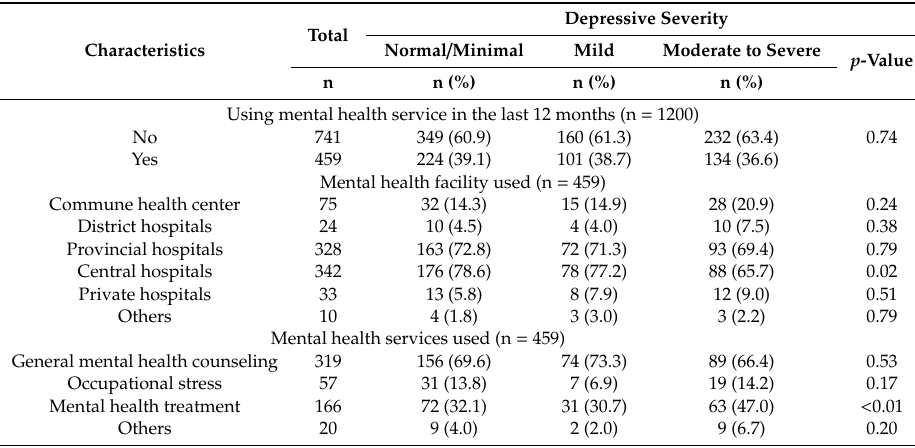
Table 3. Healthcare and mental health service